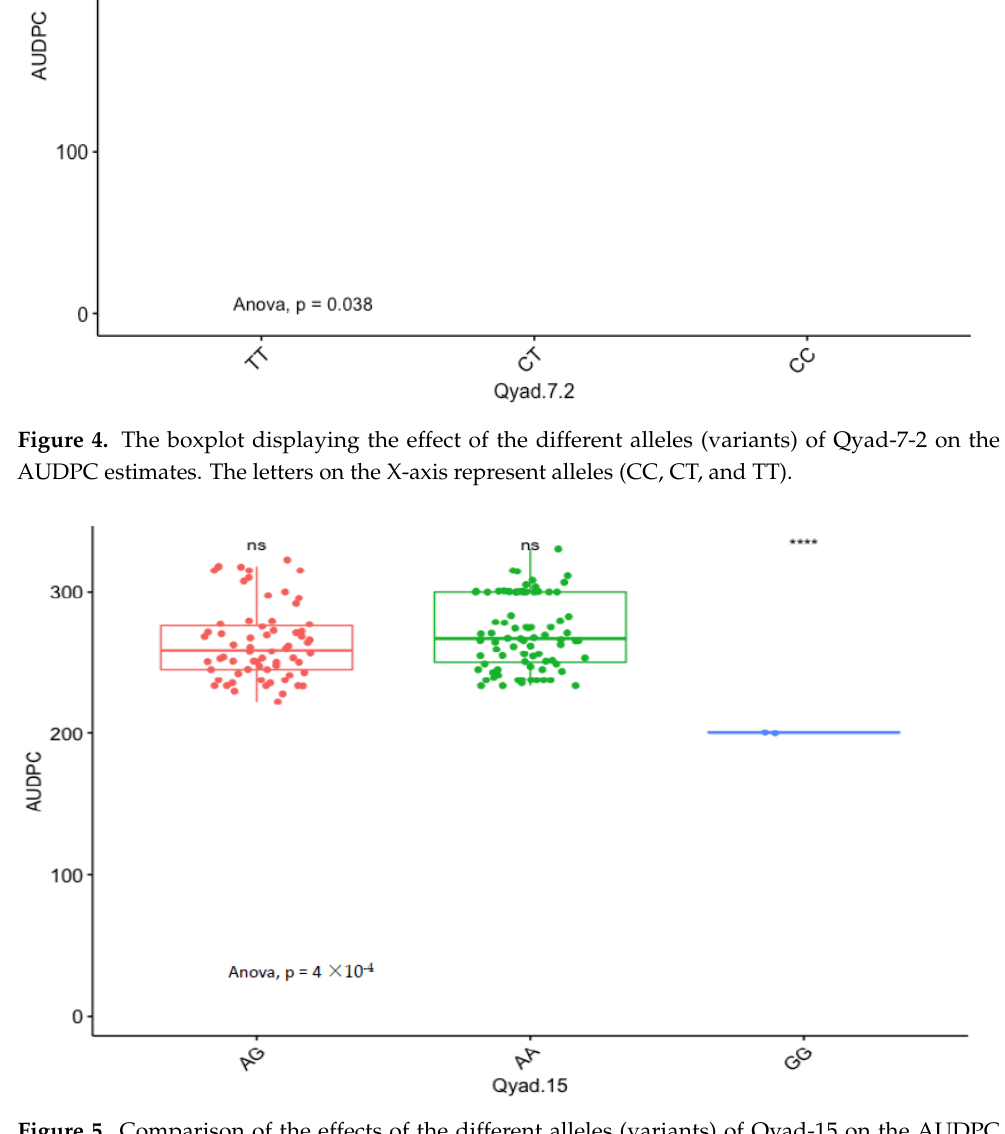
Figure 6. Comparisons of allelic effects of the QTL Qyad-18 on AUDPC estimates in the study pop- ulation. The letters on the X-axis represent alleles (AG and GG), ** and *** are statistical significance at p values 0.05 and 0.001